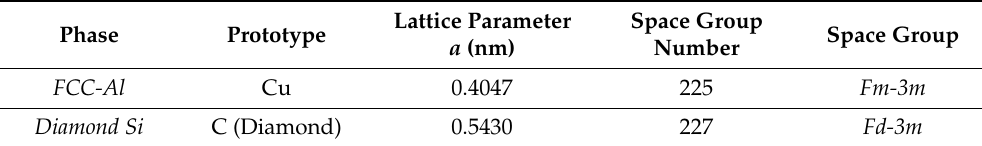
Table 4. Crystallographic data of the solid phases in the Al–Si binary systems. Lattice Parameter Space Group Space Group Phase Prototype a (nm) Number FCC-Al Cu 0.4047 225 Fm-3m Diamond Si C (Diamond) 0.5430 227